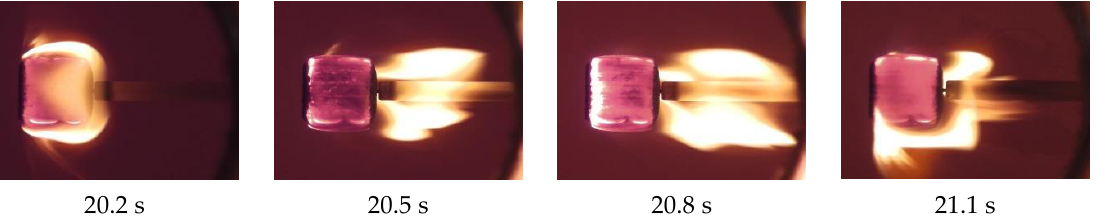
Figure 7. One of the cycles of changing the position of the flame during combustion of the particle (T